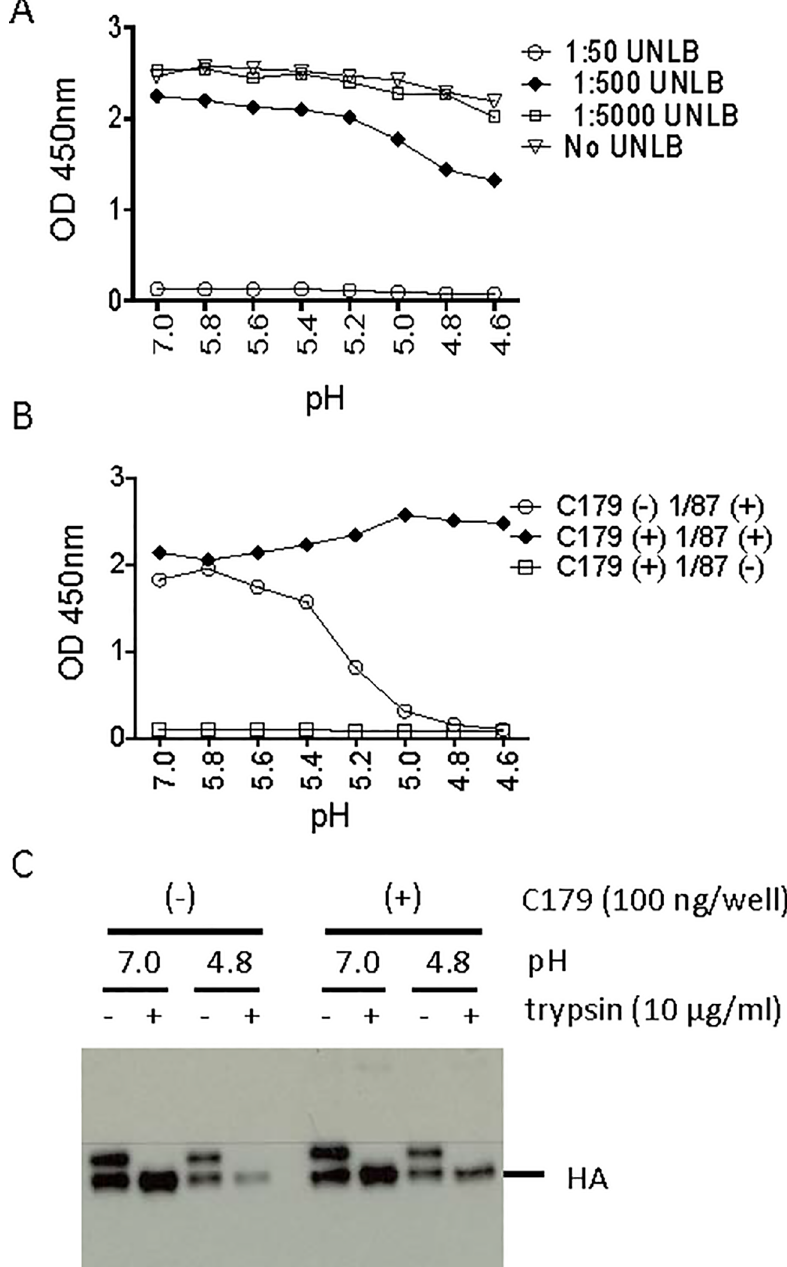
Fig 3. Inhibition of H2 rHA low pH induced conformational change by mAb C179. A. 1:50 unlabeled goat anti- mouse IgG (UNLB, Southern Biotech, AL) completely masked C179 that bound to H2 rHA. Because both C179 and 1/ 87 are mouse mAbs, a blocking step was required for detection specificity. H2 rHA coated nickel plates were incubated with 100 ng/well of C179 for 1 hour followed by incubation with diluent only, 1:5000, 1:500, or 1:50 diluted UNLB for 1 hour. The effects of this blocking step was confirmed by ELISA using HRP-conjugated goat anti mouse IgG (SouthernBiotech, AL). B. H2 rHA was bound to a nickel-coated 96-well plate, treated with 200 ng/ml trypsin, then incubated with or without mAb C179 (100 ng/well), and treated with pH adjusted buffer in 0.2 unit increments ranging from pH 4.6–5.8 and pH 7.0. The plate was washed once with PBS followed by blocking with UNLB (1:50), H2 rHA was fixed with 0.05% glutaraldehyde/PBS and washed. To ascertain the conformation of H2 rHA, the plates were incubated with the pH specific mAb 1/87 followed by incubation with an HRP-conjugated goat anti-mouse IgG. Reactions were terminated and the OD 450 nm was measured in ELISA. C. To confirm the results in Fig 3B, the protease susceptibility assay was performed without the blocking step. H2 rHA was bound to a nickel-coated 96-well